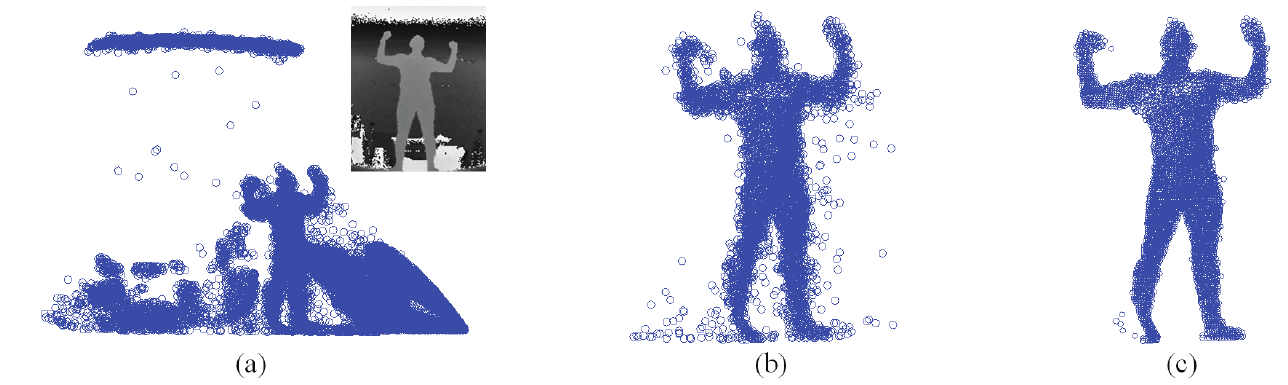
Figure 17. The illustration for depth data pre-processing. ( a ) The point set transferred from a depth image; ( b ) The point set after background subtraction; ( c ) The point set after denoising.